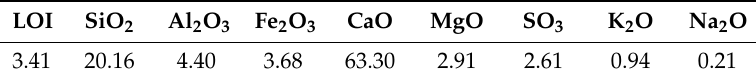
Table 1. Chemical properties of ordinary Portland Cement.